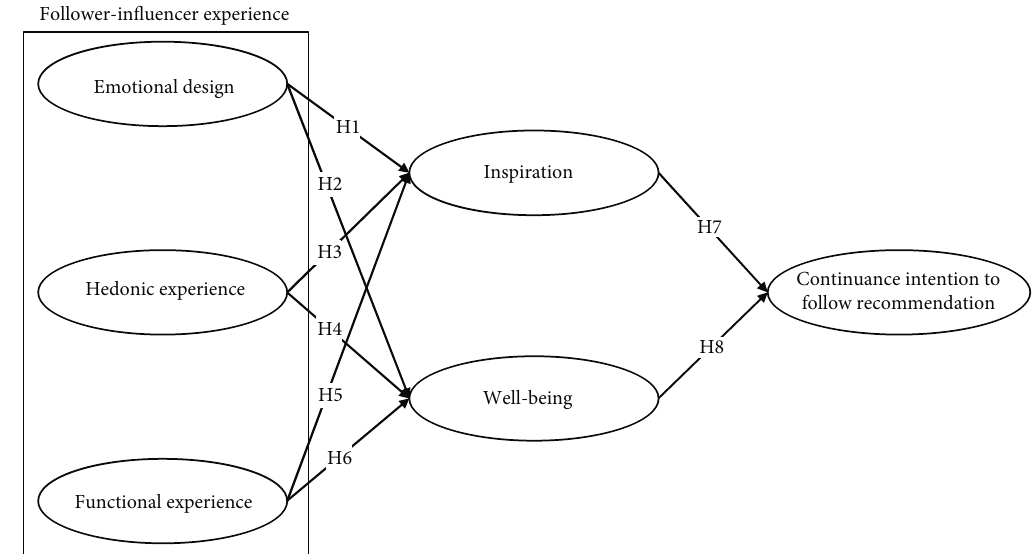
Figure 1: Proposed research